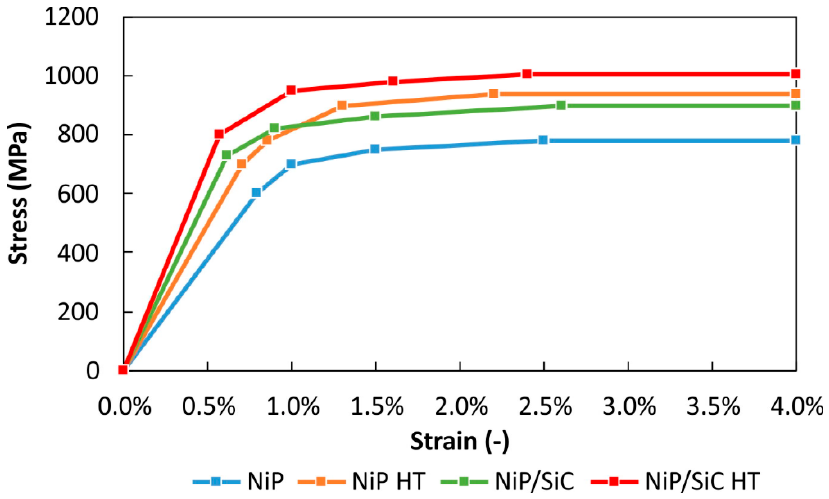
Figure 10. Analytical-experimental determined stress-strain curves of Ni-P and Ni-P/SiC nanocomposite coatings.